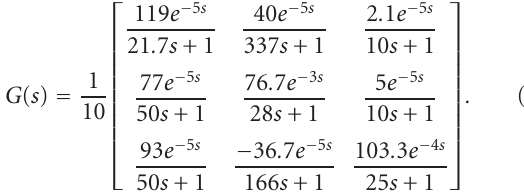
There are three nonlinearities in the diagonal. Figure 14 shows nonlinearities. Figure 15(a) shows root loci of pos- sible solutions of limit cycles in the N 1 ( a 1 ) versus N 2 ( a 2 ) plane for specified values of N 3 ( a 3 ). The ω max -locus shows connections of each ω max point of constant- N 3 ( a 3 )